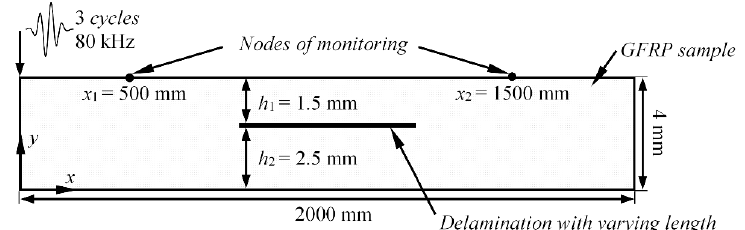
Figure 8. Sketch of the numerical model used for the validation of predictions (the sketch of the model is not to scale).